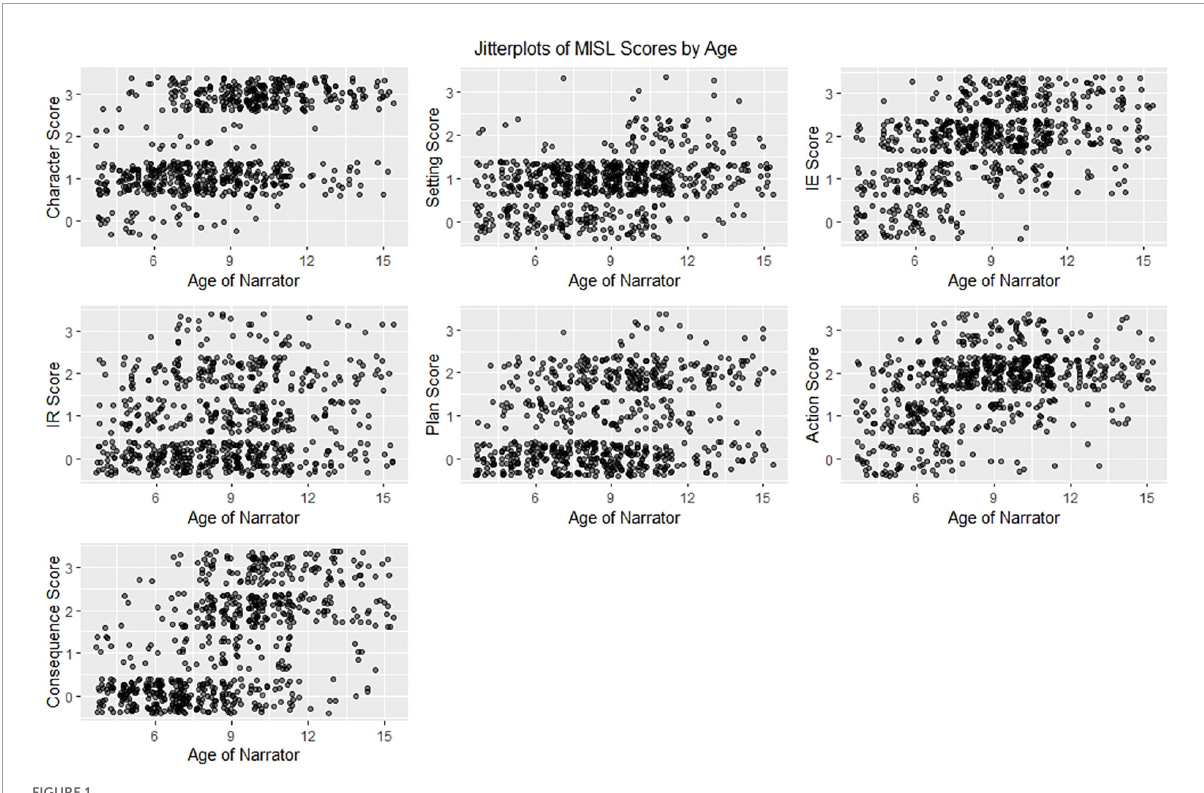
FIGURE1 IE, initiating event; IR, internal response.